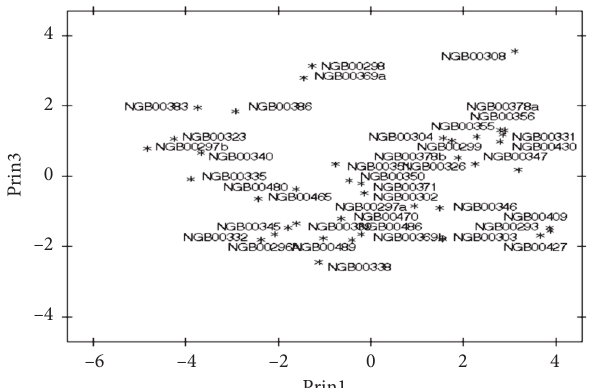
Figure 7: Configuration of the 40 okra genotypes under principal components 1 and 3.